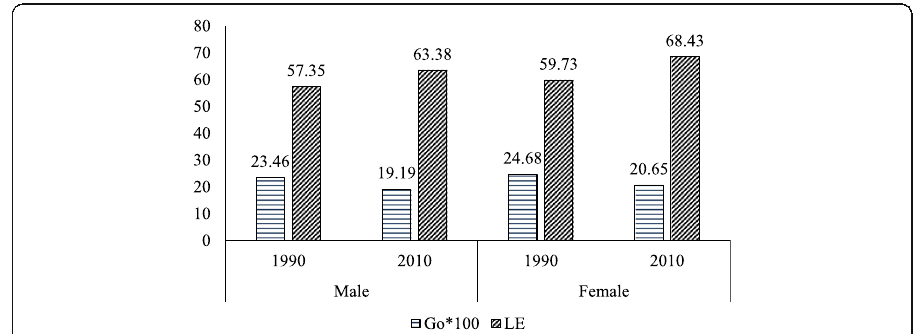
Fig. 3 Life expectancy at birth and Gini coefficient for men and women, India, 1990 and